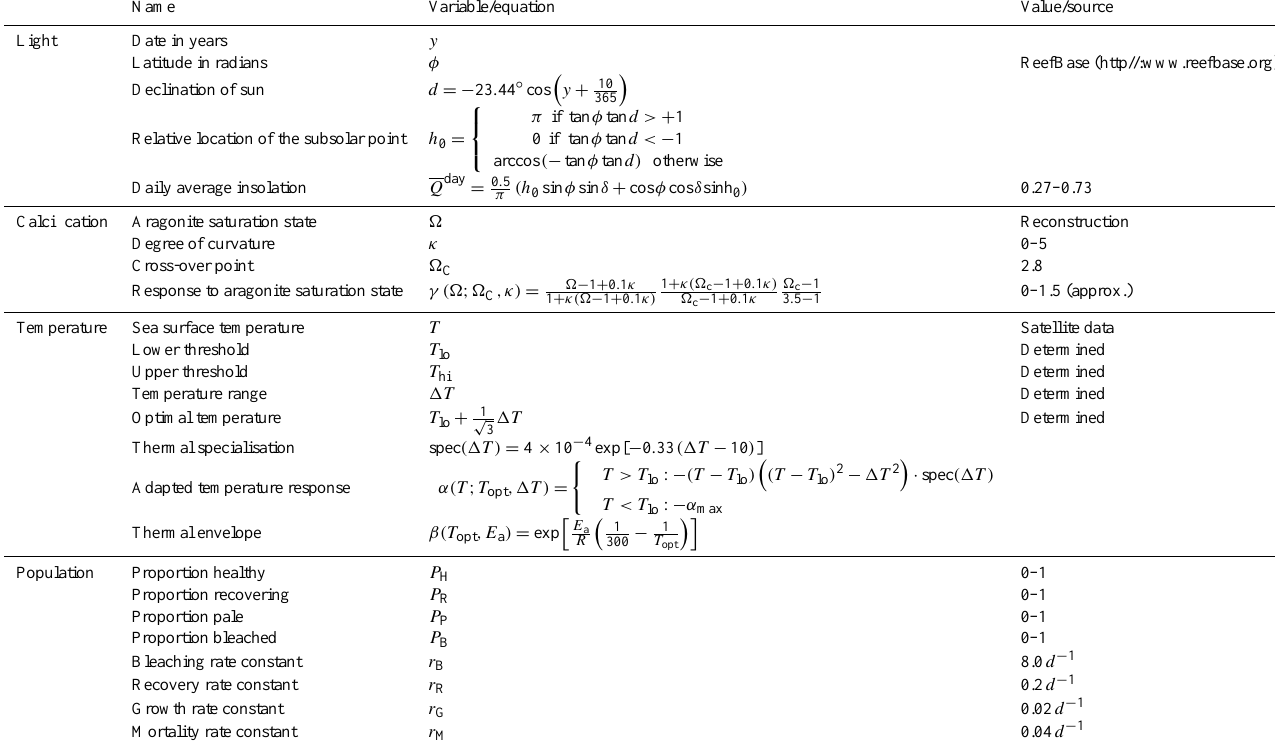
Table A1. Appendix of terms used in the